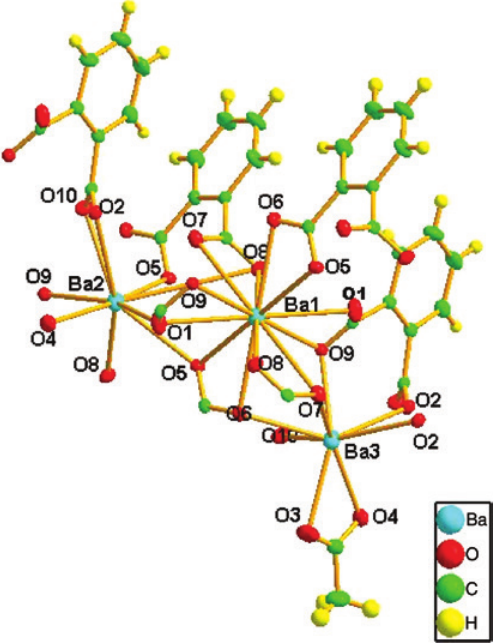
Figure 3: View of the coordination environments of barium atoms.